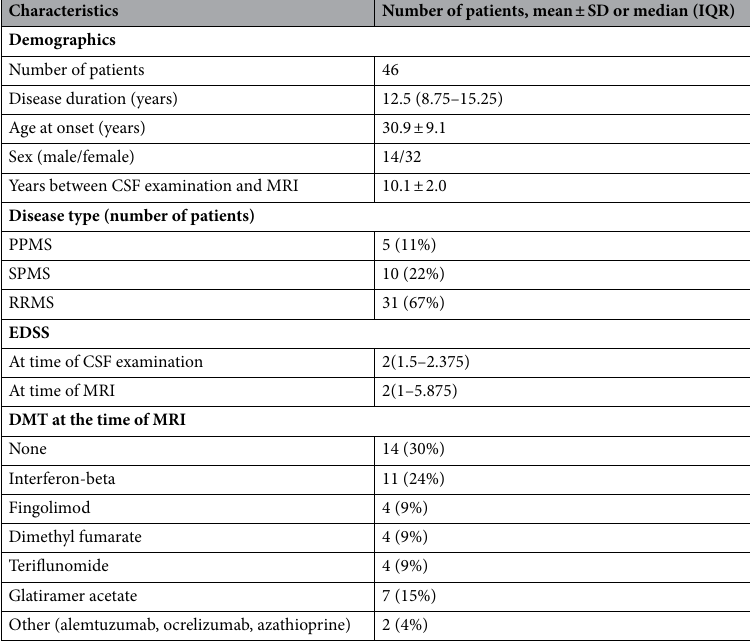
Table 1. Clinical characteristics of MS patients. Normally distributed data are reported as mean ± SD, non- normally distributed data are reported as median (25–75% interquartile range). PPMS